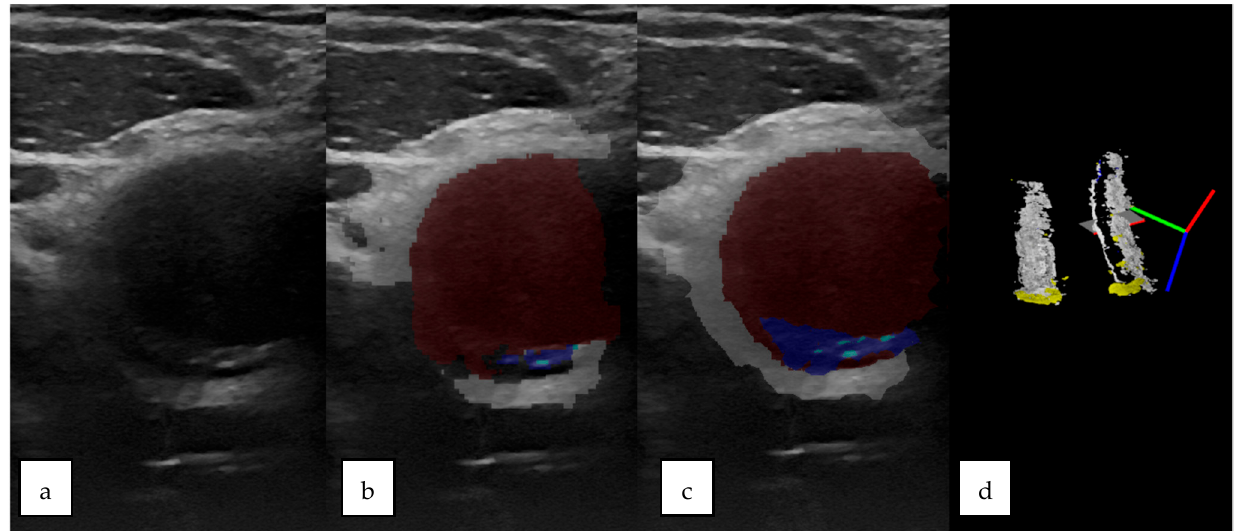
Figure 4. ( a ) Original US image and ( b ) CNN-based automatic segmentation. Arterial wall—white, calcified plaque—light blue, soft plaque—dark blue, circulated lumen—red. ( c ) Masks generated by the operator and ( d ) 3D US reconstructions of the scanned area, based on masks generated with CNN-based automatic segmentation.